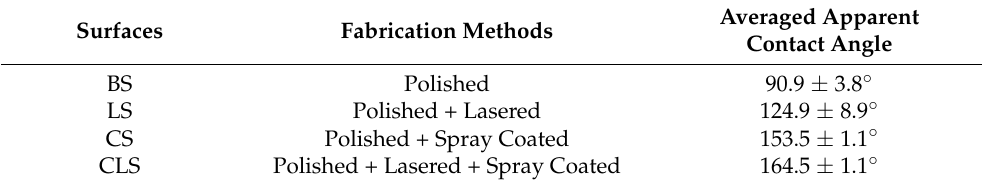
Figure 2. Contact angle measurements of brass substrate with ( a ) BS, ( b ) LS, ( c ) CS, and ( d ) CLS. Table 1. Averaged apparent contact angles and fabrication methods of all